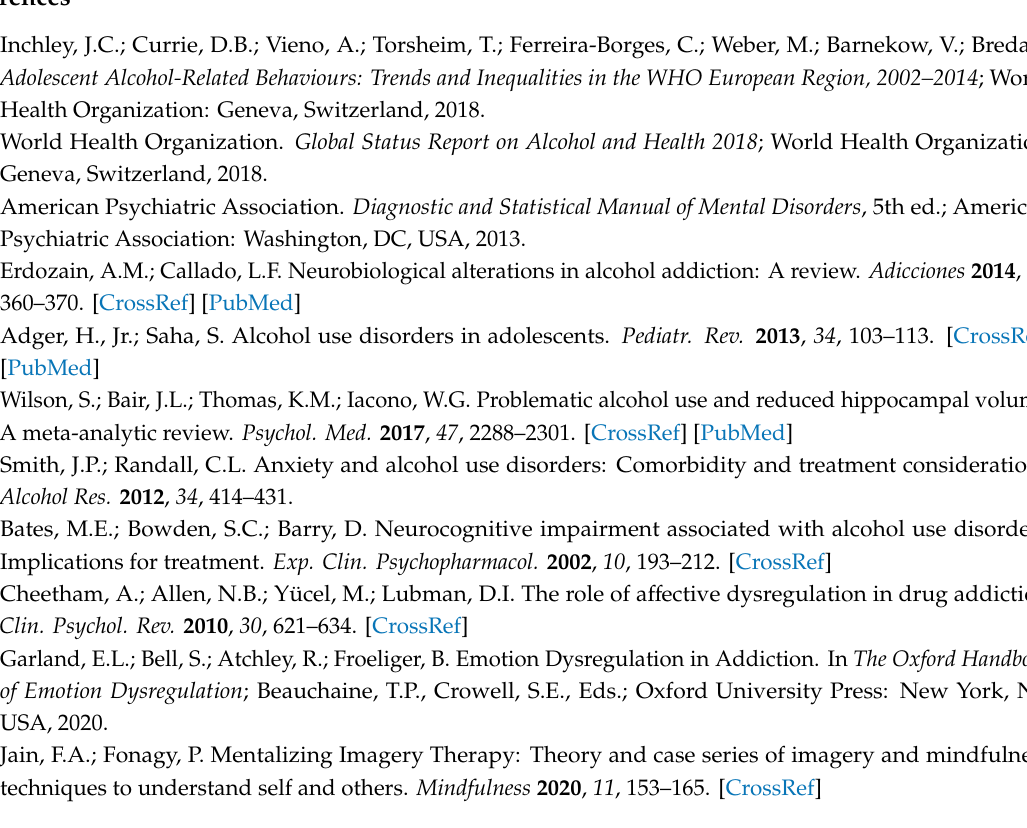
Table S1: Di ff erences between younger (18–24) and older (25–34) young